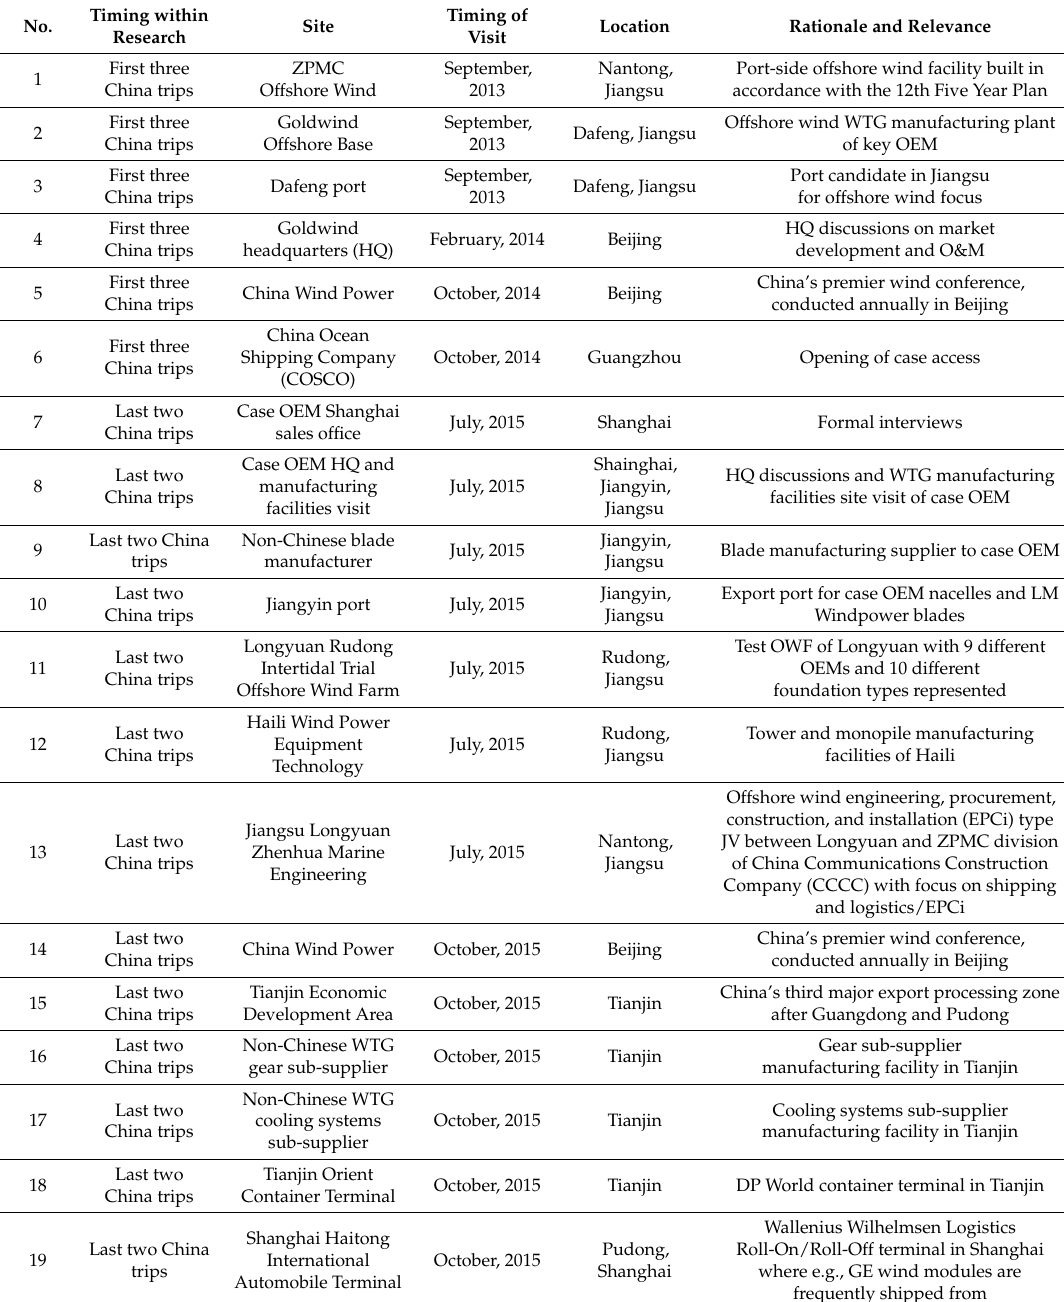
Table 4. Participant observation examples from the primary empirical data collection efforts—site visits during the five trips performed to